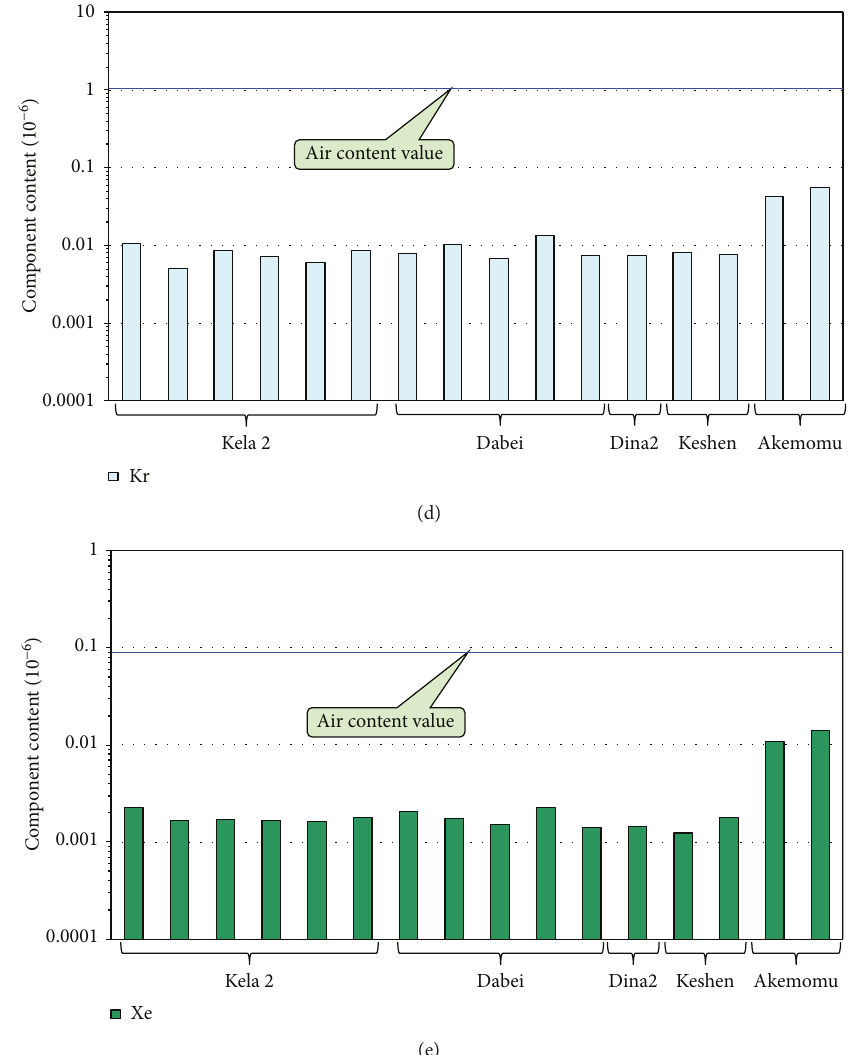
Figure 2: Histogram of helium, neon, argon, krypton, and xenon abundances in some gas fi elds from the Kuche and Southwestern Depressions, Tarim